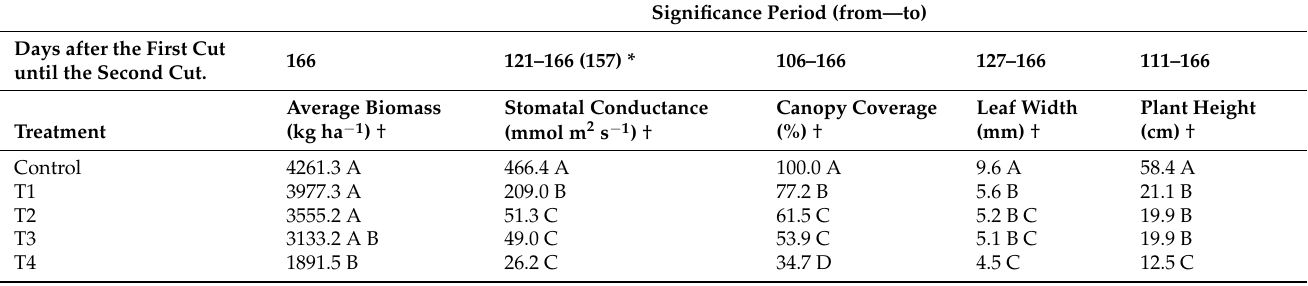
Table 4. Effect of water stress treatments on the response variables in the second crop cycle ryegrass ( Lolium perenne ). Significance Period (from—to) Days after the First Cut until the Second